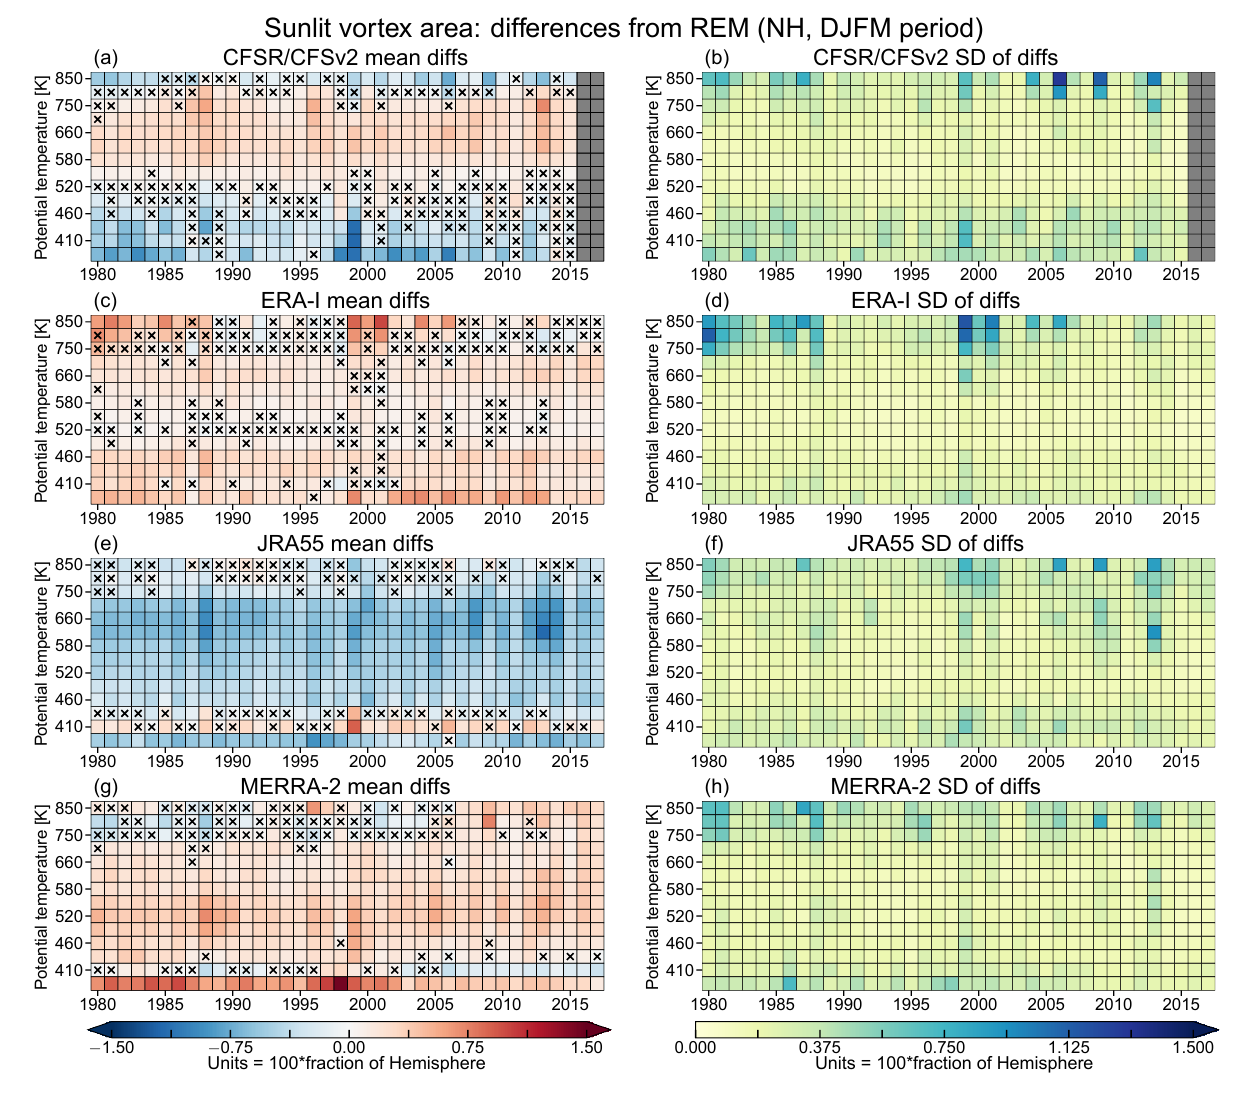
Figure 14. As in Fig. 13 but for the